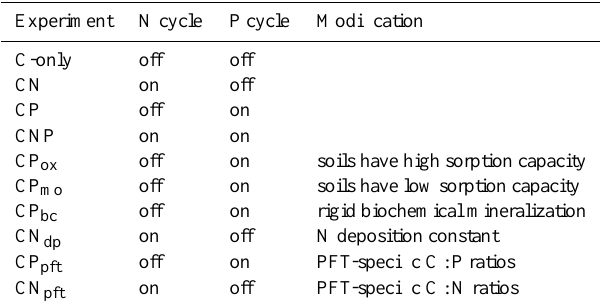
Table 3. List of experiments performed. The climatic forcing is the same for all simulations. See Appendix C for further simulations regarding the stoichiometric